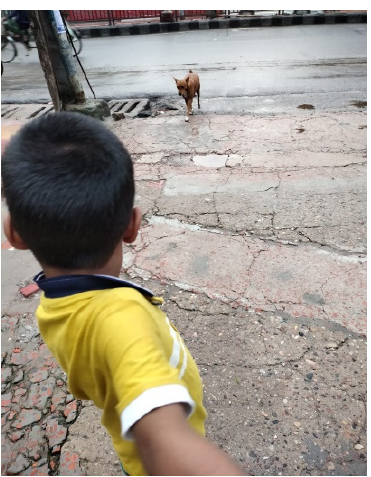
Figure 2. Alt-text: A boy in a yellow shirt turning to look at a dog on the road.